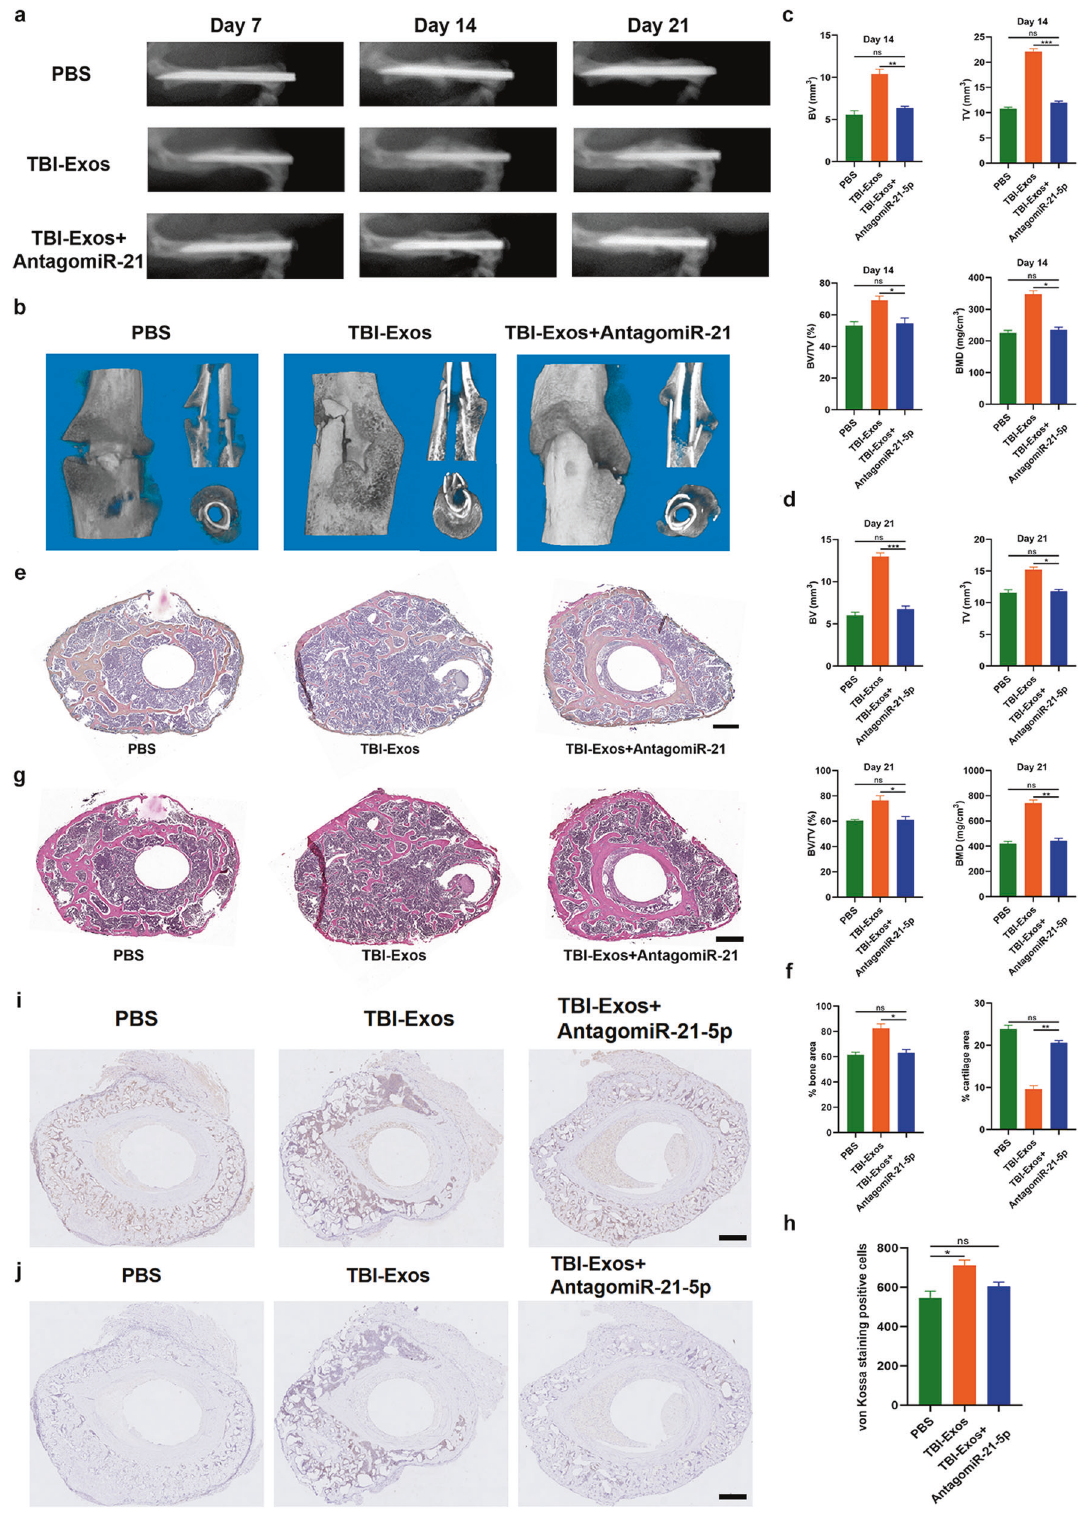
Fig. 5 Exosomal miR-21-5 p promotes fracture healing in vivo. a , b The healing processes in the mouse model with different treatments were assessed by X-ray ( a ) and micro-CT analysis ( b ). c , d The CT Analyzer was used to measure the BV, TV, BV/TV and BMD results of mice on Day 14 and Day 21 after fracture. e , h The ABHEOG and Von Kossa staining results of mice on Day 21 after fracture, scale bar: 200 μ m. i , j CD31 and Ki67 immunohistochemistry of the callus in different groups, scale bar: 500 μ m. Data are the mean ± SD of triplicate experiments. * p < 0.05, ** p < 0.01, *** p <